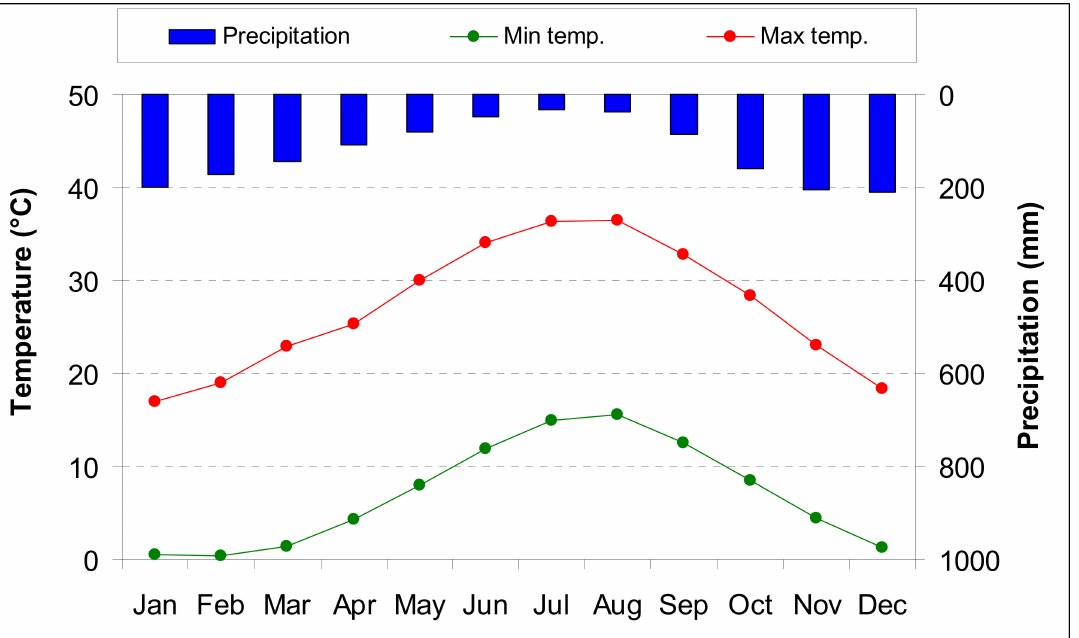
Figure 2. Monthly patterns of precipitation and temperature for the meteorological station of Cit- tanova (Calabria, Southern Italy, data of the period 1924–2018, data source: